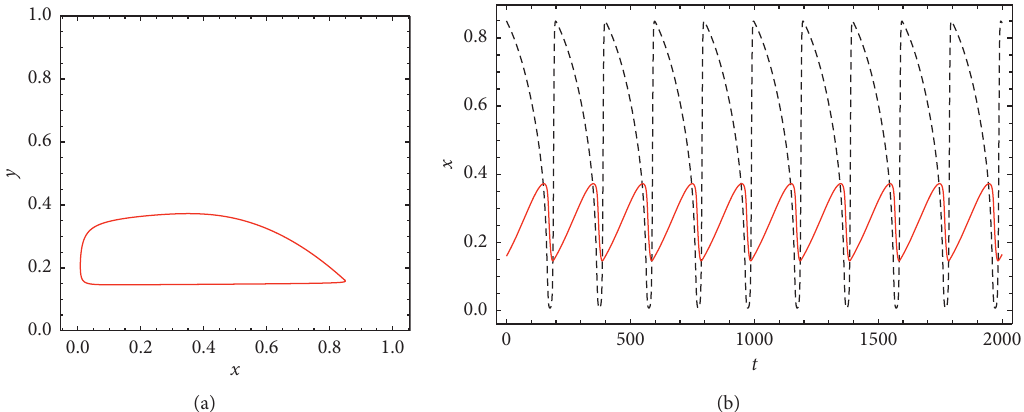
Figure 7: Choose ( τ black dashed curve (prey) and red full curve